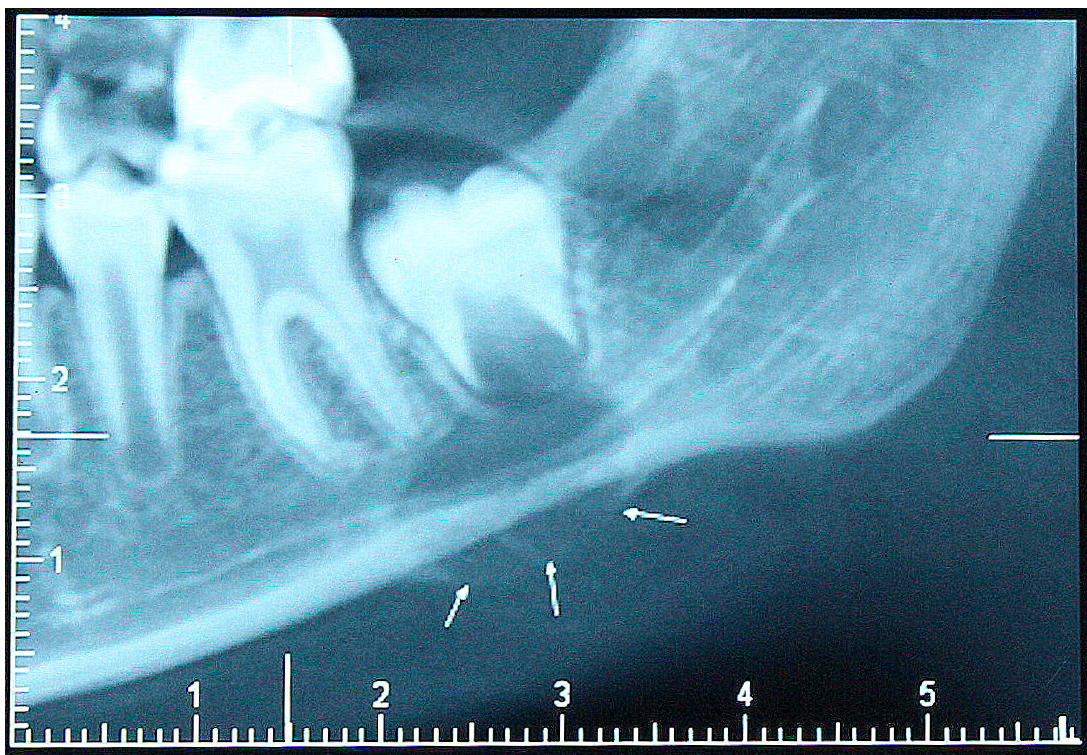
Figure 1. Cone beam computed tomographic image shows a well-defined radiolucent lesion around the root of developing second molar and concomitant expansion of the facial cortical bone.